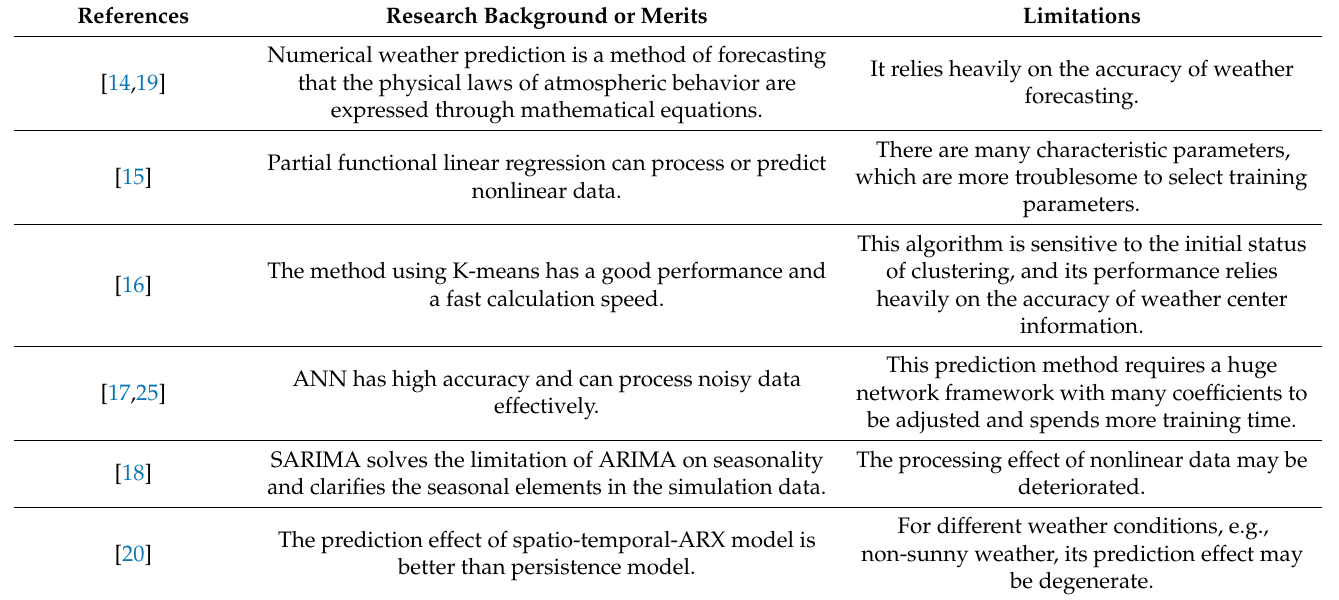
Table 1. Summary of research background and merits/limitation of previous